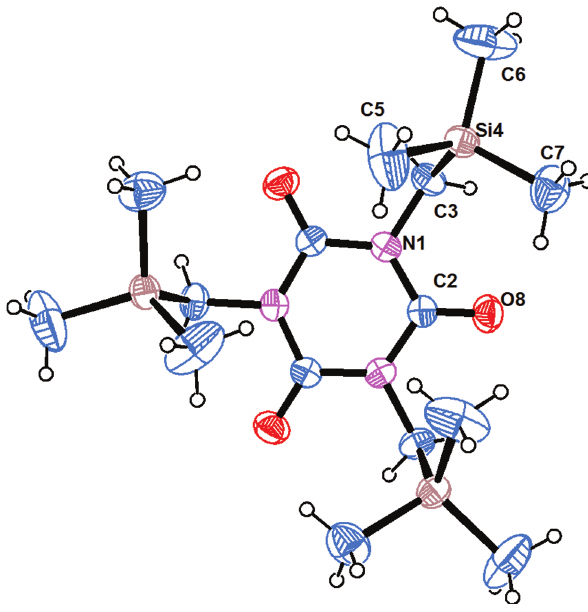
Table 1: Data collection and handling.